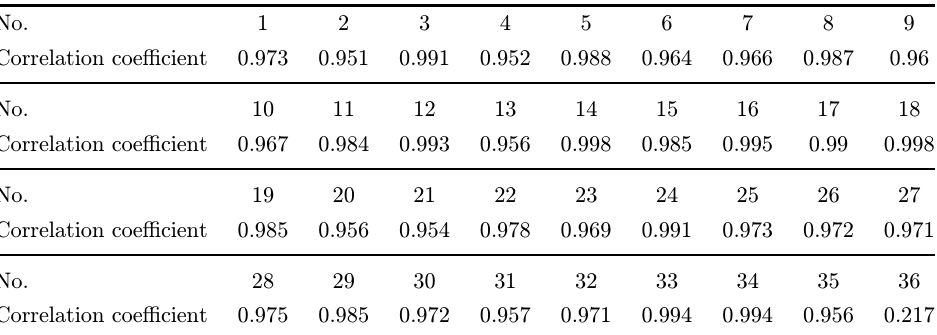
Table 7. Metformin near-infrared spectral images correlation